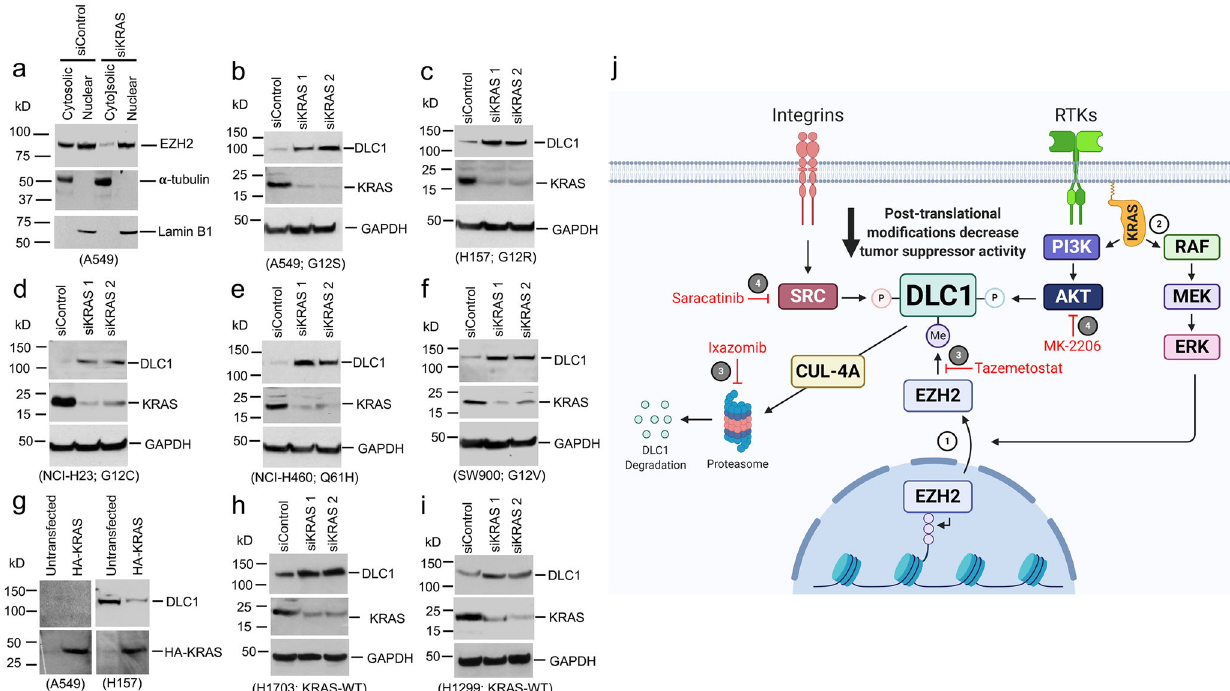
Fig. 10 Cytoplasmic EZH2 mediates an inverse relationship between KRAS and DLC1 protein; and a model for regulation of DLC1 by cytoplasmic EZH2. a siRNA knockdown of KRAS drastically reduced cytoplasmic EZH2 protein in LUAD A549 cells. Cells were transfected with control siRNA or KRAS siRNA for 48 h, purity of nuclear and cytosolic fractions was con fi rmed by nuclear (Lamin-B1) and cytosolic ( α -Tubulin) marker proteins. b – f siRNAs knockdown of KRAS increased DLC1 protein level in mutant KRAS lung cancer lines. Five different cell lines with mutant KRAS (mutant alleles indicated below the relevant panel) were transfected with two different KRAS siRNAs for 48 h, and the lysates were immunoblotted for KRAS and DLC1 protein. g Transfection of KRAS-G12C mutant reduced DLC1 protein in H157 cells. A549 and H157 cells were transiently transfected with HA-tagged KRAS-G12C mutant for 48 h, and the lysates were immunoblotted with DLC1 (top) and HA (bottom) antibodies. h , i siRNAs knockdown of KRAS increased DLC1 protein level in wild- type KRAS lung cancer lines. Two different cell lines with wild-type KRAS were transfected with two different KRAS siRNAs for 48 h, and the lysates were immunoblotted for KRAS and DLC1 protein. Two independent experiments were performed for a – i with similar results. j Model summarizing the main fi ndings of this study. Mutant KRAS promotes the cytoplasmic localization of EZH2 protein, which is, in turn, methylates DLC1 protein, leading to CUL-4A ubiquitin-dependent proteasomal degradation of DLC1 protein. EZH2 and proteasomal inhibition prevent this degradation process, resulting in DLC1 protein stabilization. The phosphorylation of DLC1 protein by AKT and SRC kinases, which reduce the tumor suppressor activity of DLC1 protein, can be reversed by inhibitors of AKT and SRC kinases, thereby increasing the tumor suppressor activity of DLC1 protein. Source data are provided as a Source Data fi